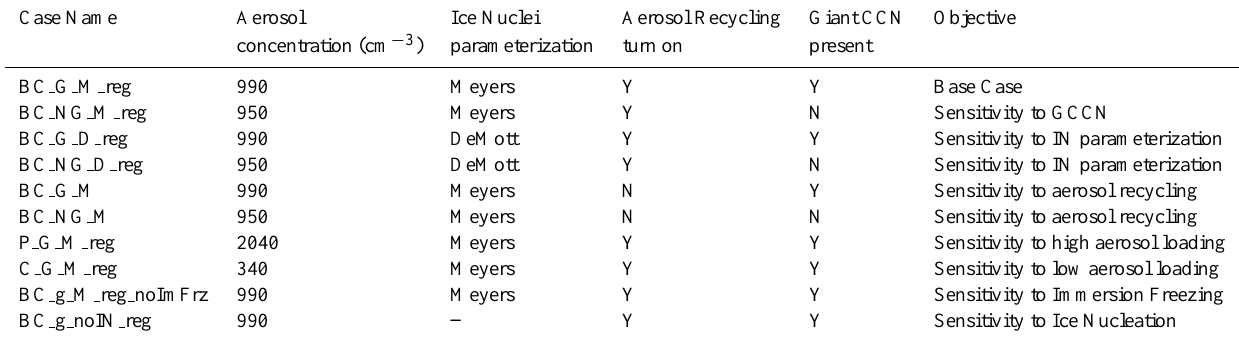
Fig. 4. Spatial distribution of total precipitation (in mm) between 06:00 and 12:00UT in a few of the case studies. The red rectangle marks the area which will be under attention in the remaining analysis. Figure (c) shows the difference between cases BC G M reg and C NG M reg. Table 1. Names and description of the